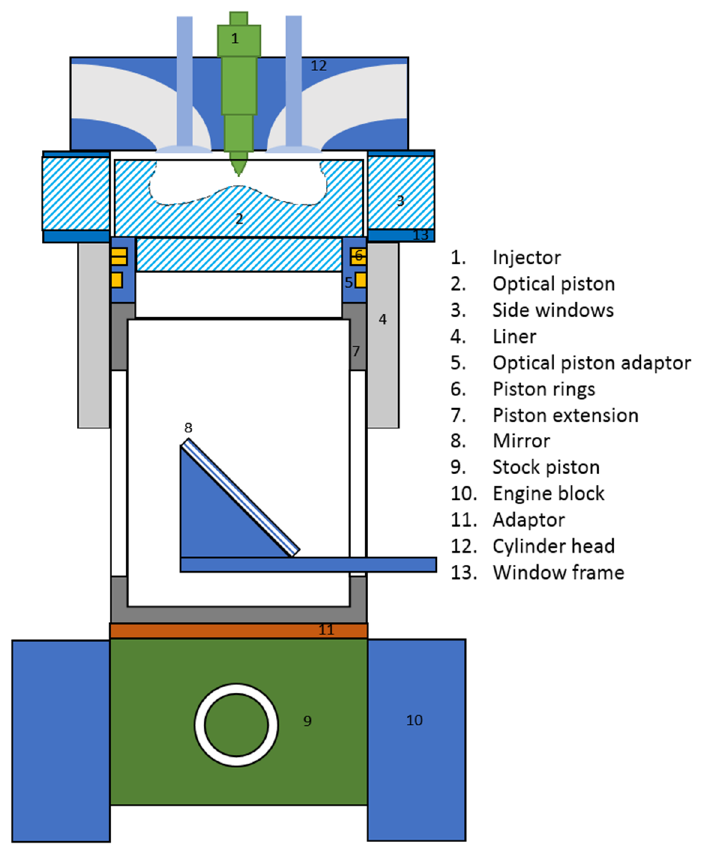
Figure 1. A side view of a research engine equipped with optical access from below via an elongated piston (the Bowditch design) and from the sides via a cylinder quartz ring, inserted as part of the cylinder